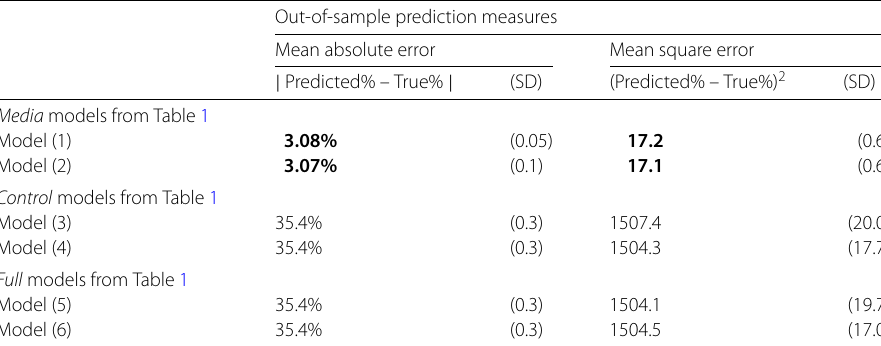
Table 2 Out-of-sample results. Comparison of models in Table 1 with respect to out-of-sample-predictions. Mean square error is estimated via randomly sampling 80% of the data to estimate the model, using the remaining 20% to test the model, and repeating 100 times. SD = standard deviation. The best out-of-sample prediction statistics are reported in bold Out-of-sample prediction measures